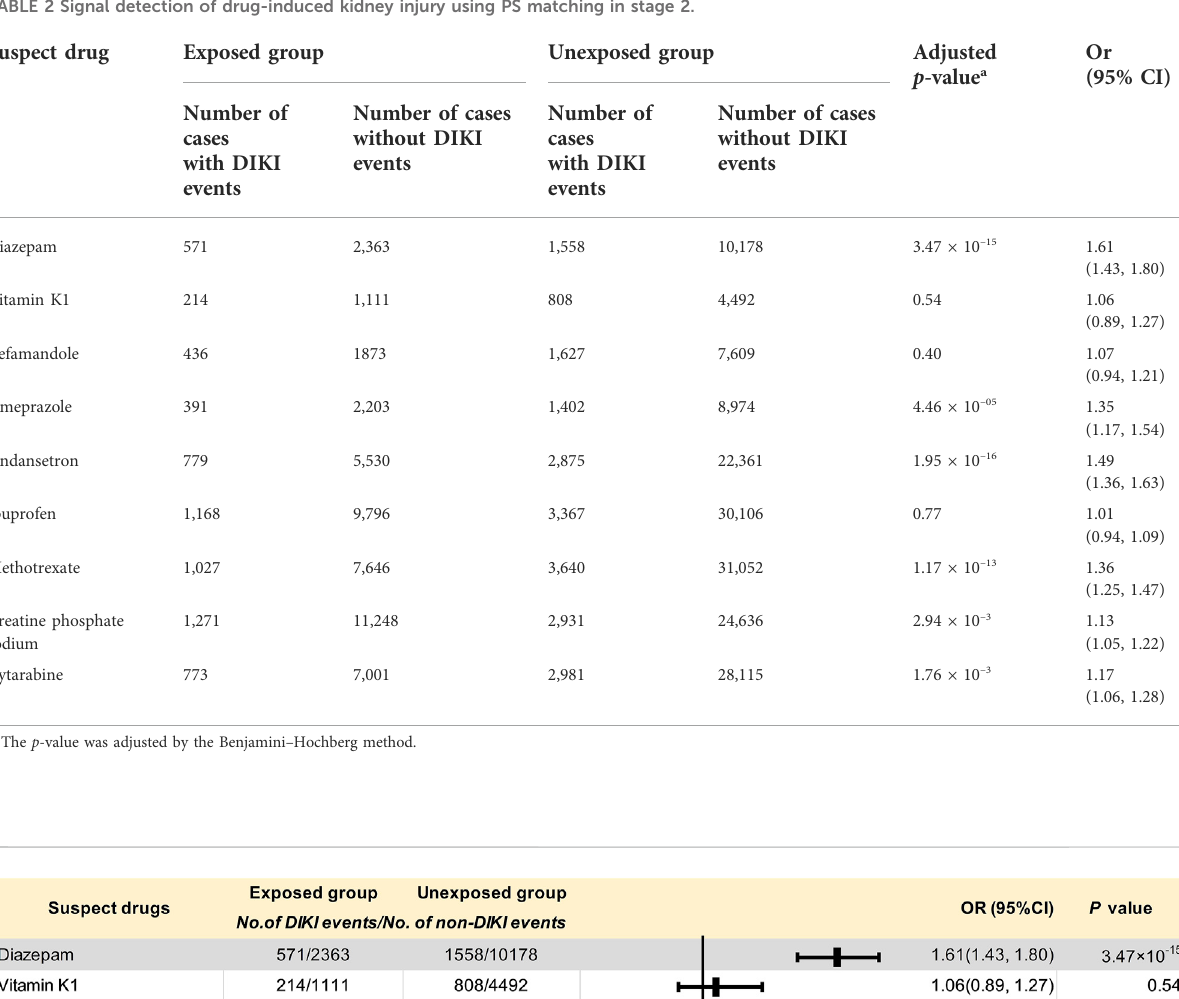
TABLE 2 Signal detection of drug-induced kidney injury using PS matching in stage 2.